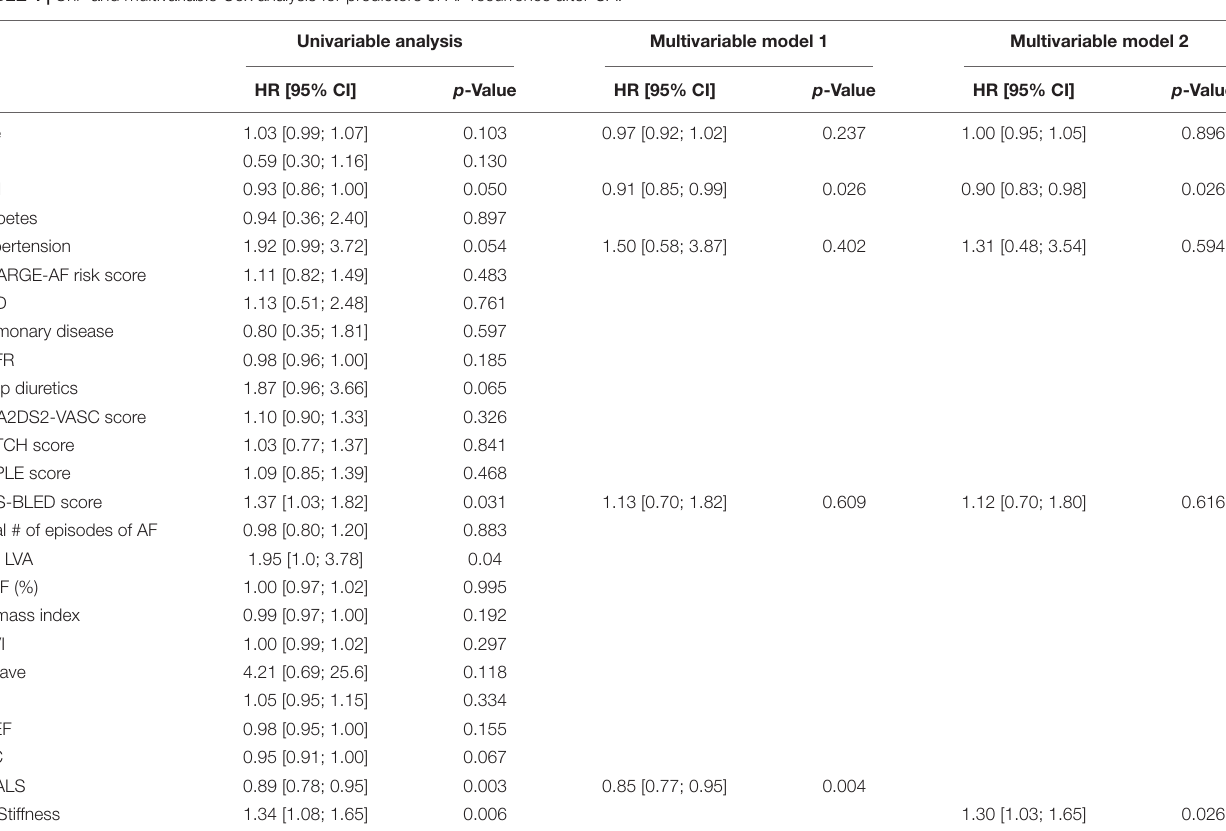
TABLE 4 | Uni- and multivariable Cox analysis for predictors of AF recurrence after